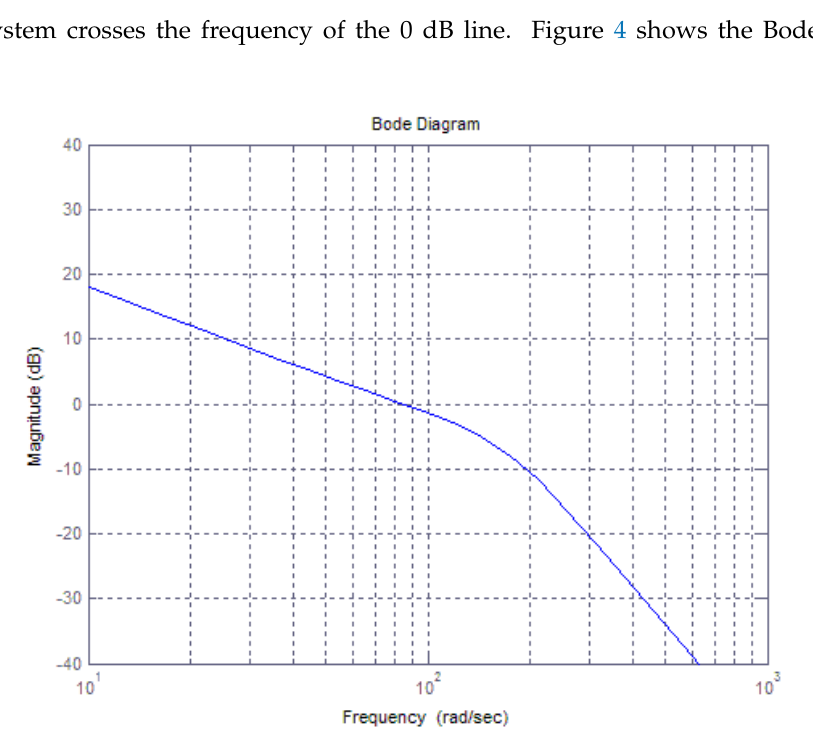
Figure 4. Bode plot of the system.